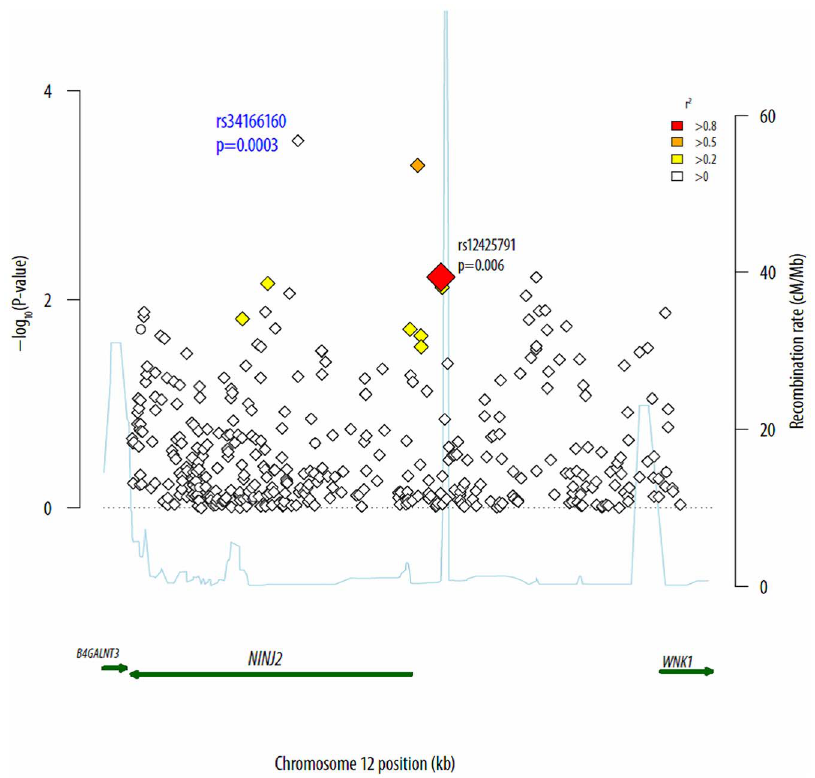
Figure 1. Associations of common variants (MAF $ 1%) with incident ischemic stroke in the CHARGE Targeted Sequencing Study. Association p-values are plotted against their genomic position.